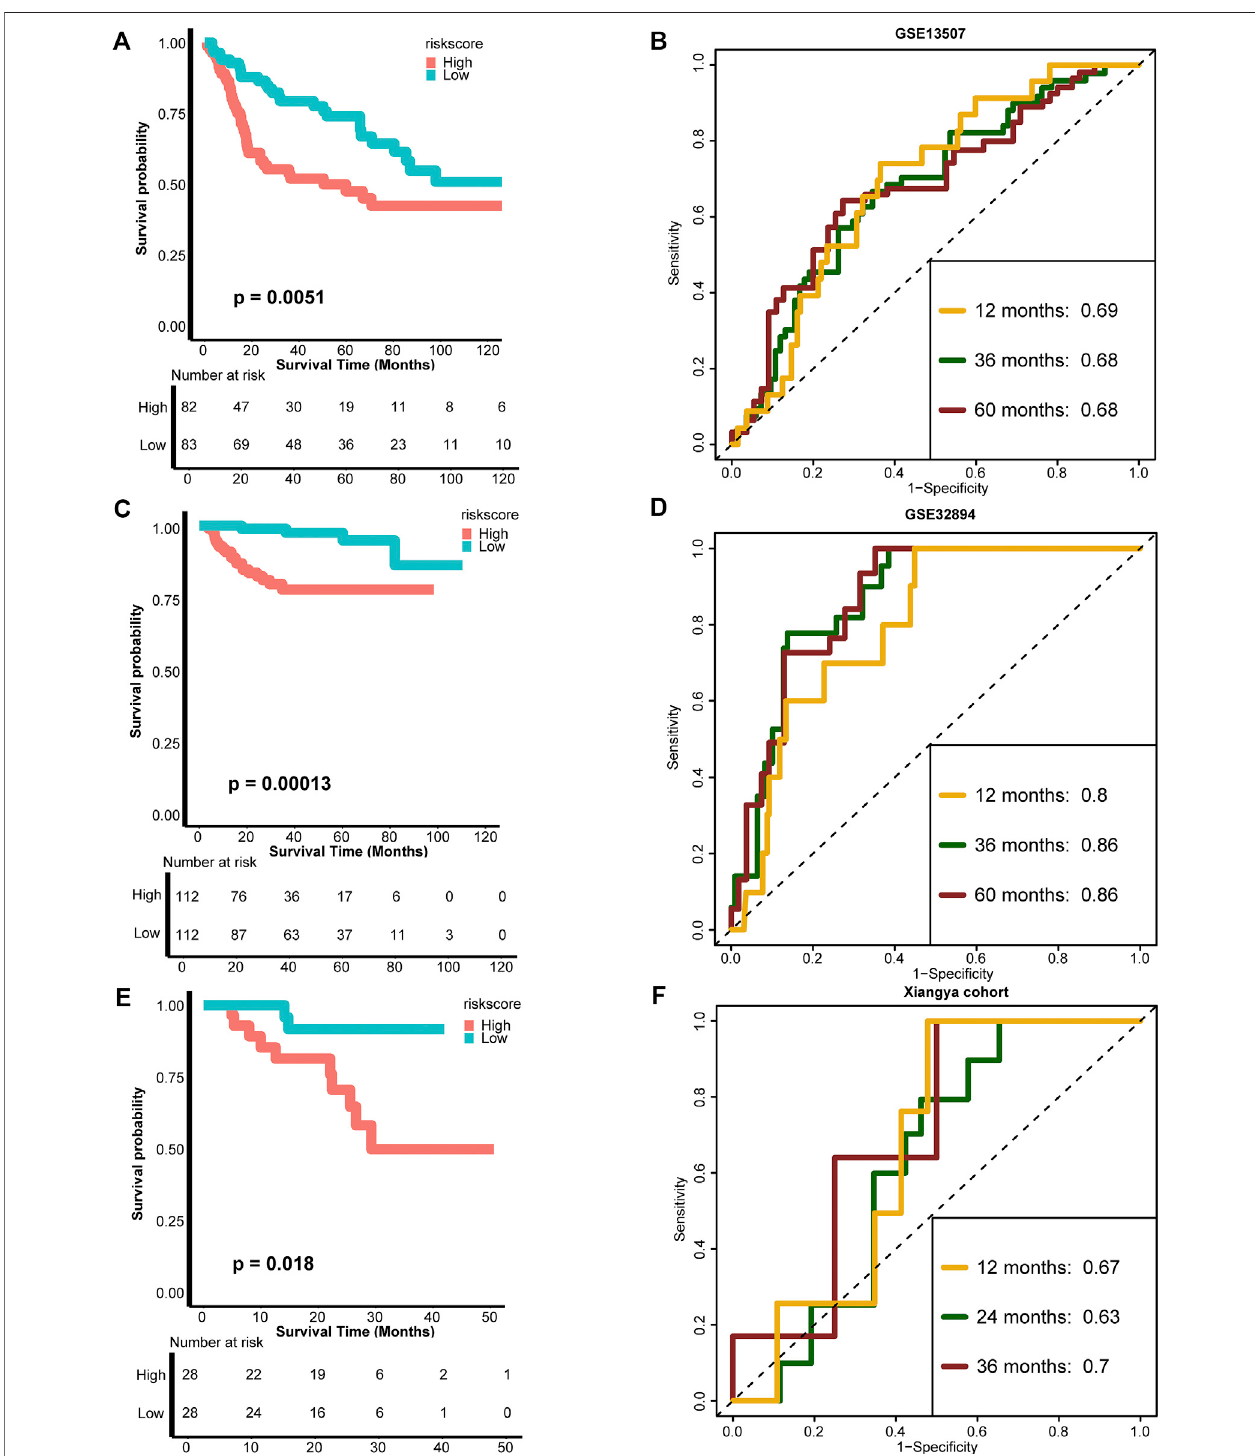
FIGURE 3 | External validation of the TNF-based risk score. (A , B) K-M plot of OS between TNF-based risk score groups and AUC plot of the risk score in the GSE13507validationcohort,respectively. (C , D) K-MplotofOSbetweenTNF-basedriskscoregroupsandAUCplotoftheriskscoreintheGSE32894validationcohort, respectively. (E , F) K-M plot of OS between TNF-based risk score groups and AUC plot of the risk score in Xiangya validation cohort, respectively. Red and azure lines represent high and low TNF-based risk score groups, respectively.